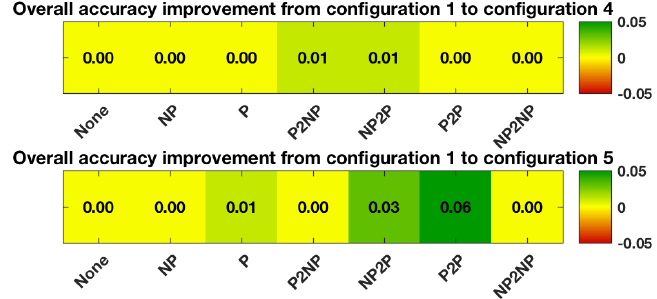
Figure 9. Overall accuracy improvements from Configuration 1 to Configuration 4 (top) and from Configuration 1 to Configuration 5 (bottom). Only the improvements with a significance level of 0.05 are